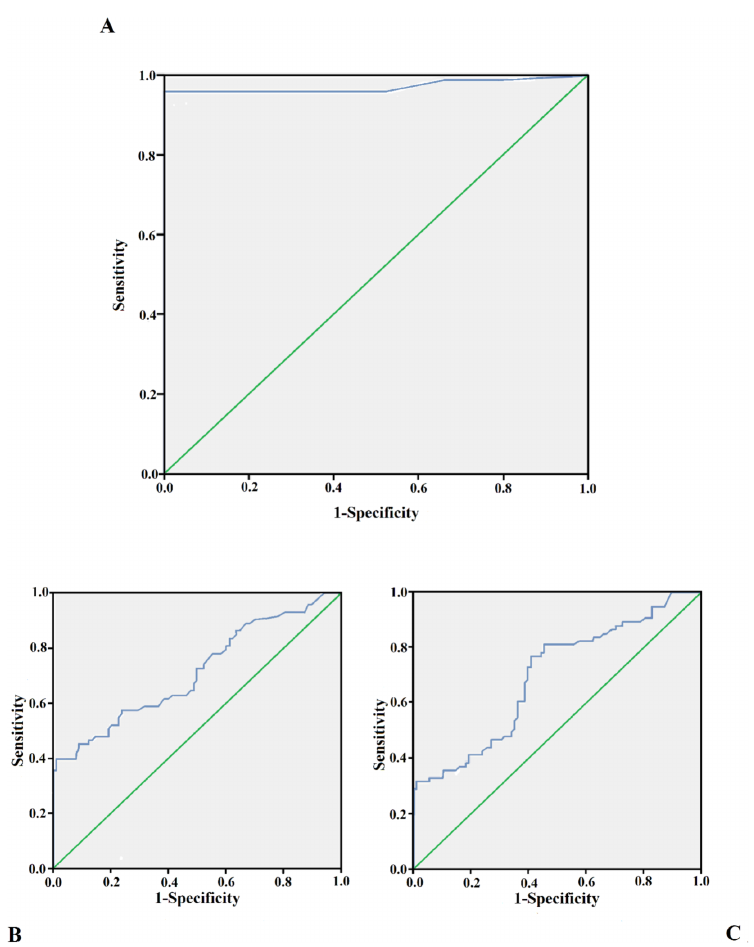
Fig 1. Receiver operator characteristic (ROC) curve. A ROC curve (blu line) plot of the LIOSpot 1 TB is shown, illustrating sensitivity and specificity for Ala-DH (A), ESAT-6 (B) and CFP-10 (C) to discriminate subjects with active TB from LTBI ones. AUC is the area delimited by the ROC curve and the green reference line.